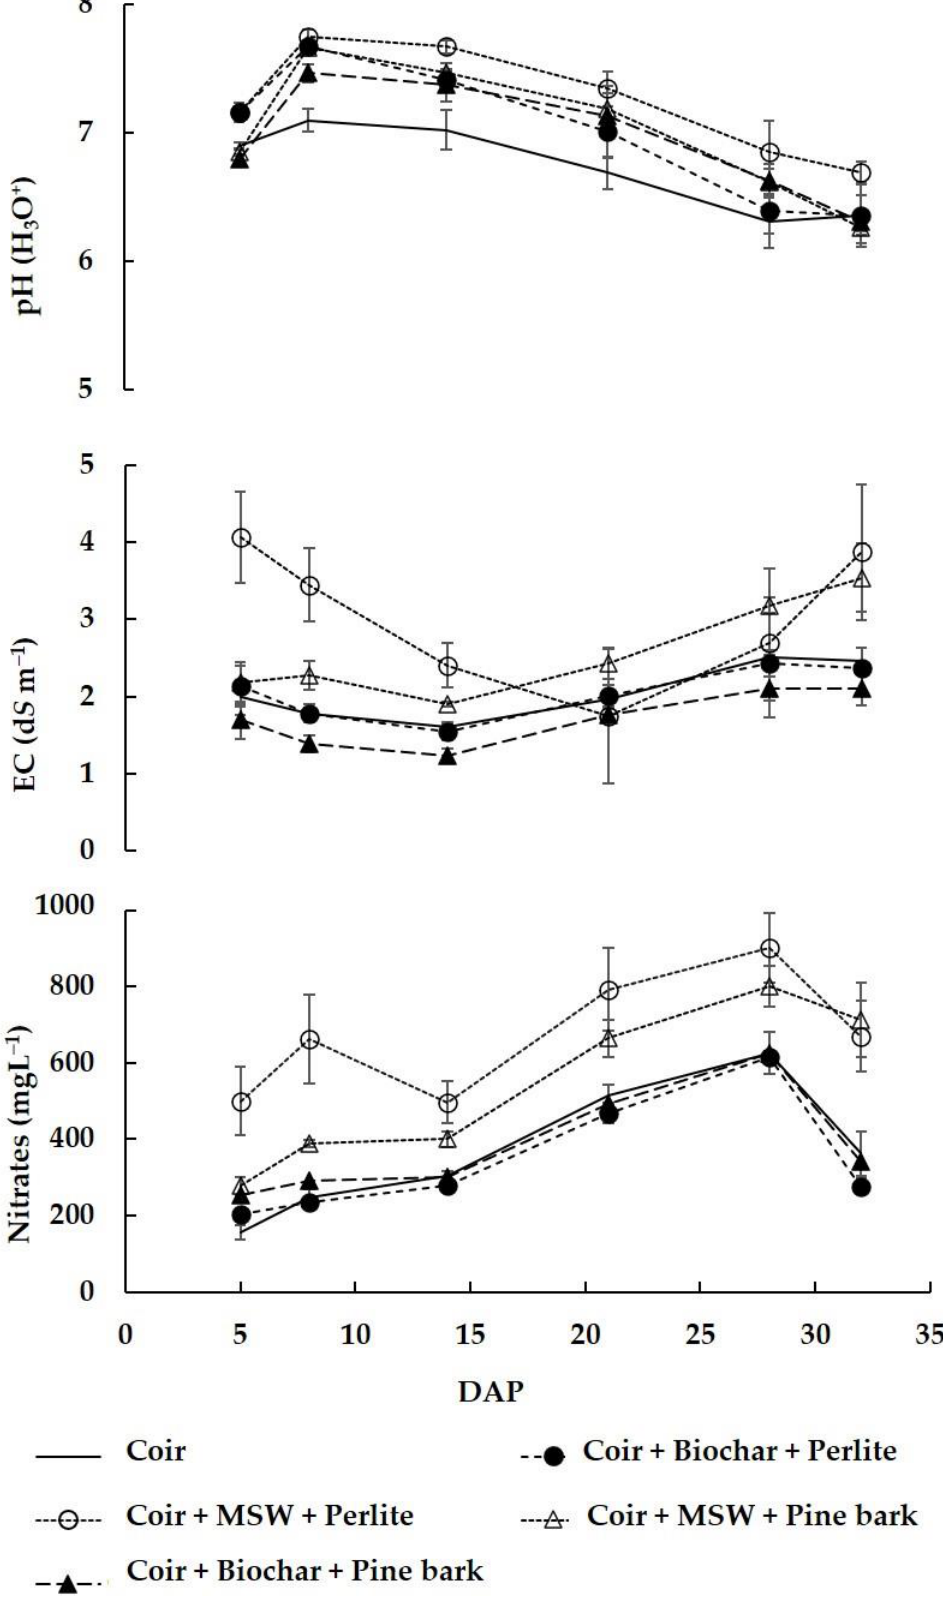
Figure 1. pH, EC, and NO 3 − concentrations in the drainage water. Each symbol represents the mean of five replicates, and the error bars represent ± 1SE.